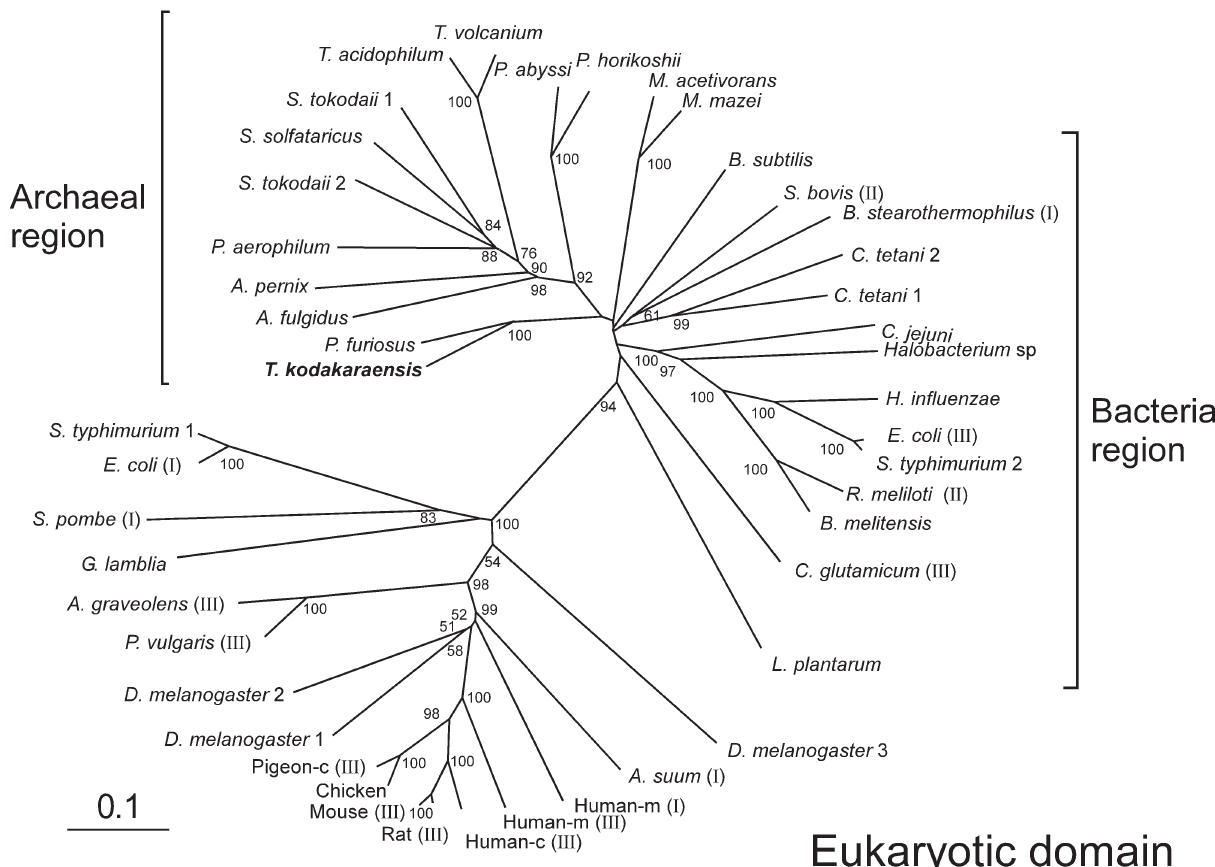
Figure 2. Radial phylogenetic tree of representative bacterial, eukaryotic and archaeal malic enzymes. Multiple sequence alignments and phylo- genetic analysis were performed with the neighbor-joining method using the the ClustalW program provided by the DNA Data Bank of Japan (DDBJ). Scale bar indicates 10 substitutions per 100 amino acids. Bootstrap resampling was performed 1000 times and only values observed in more than 50% of the replicas are shown. The accession numbers of the sequences are as follows: Aeropyrum pernix , G72731; Apium graveolens (III), Q9SDL2; Archaeoglobus fulgidus , F69465; Ascaris suum (III), S29742; Bacillusstearothermophilus (I), P16468; Bacillussubtilis , O34962; Brucella melitensis , AI3372; Campylobacter jejuni , Q9PN12; chicken, AF408407; Clostridium tetani 1, AE015937; C. tetani 2,